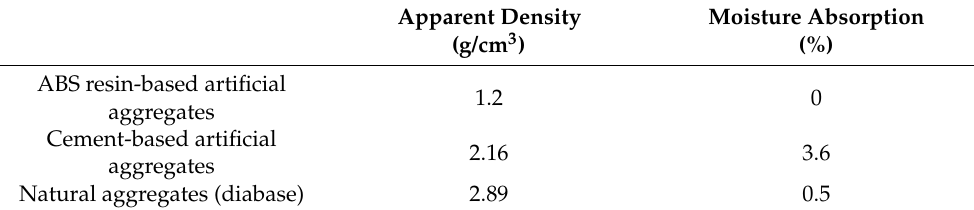
Table 11. Apparent density and water absorption of different